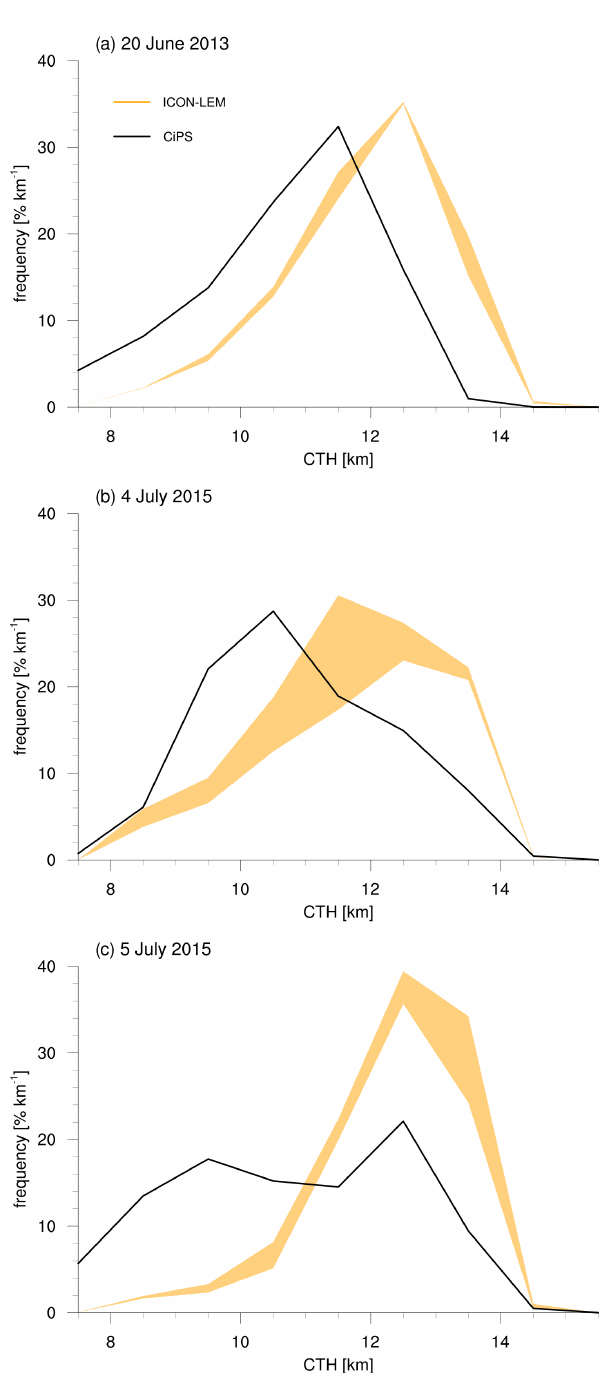
Figure 6. PDF of simulated cloud-top height for 20 June 2013 (a) , 4 July 2015 (b) , and 5 July 2015 (c) compared with CiPS. The shaded area shows the sensitivity to two different IWP thresholds (0.6 and 3.0gm − 2 ; see Sect. 4.10) considering thin cirrus